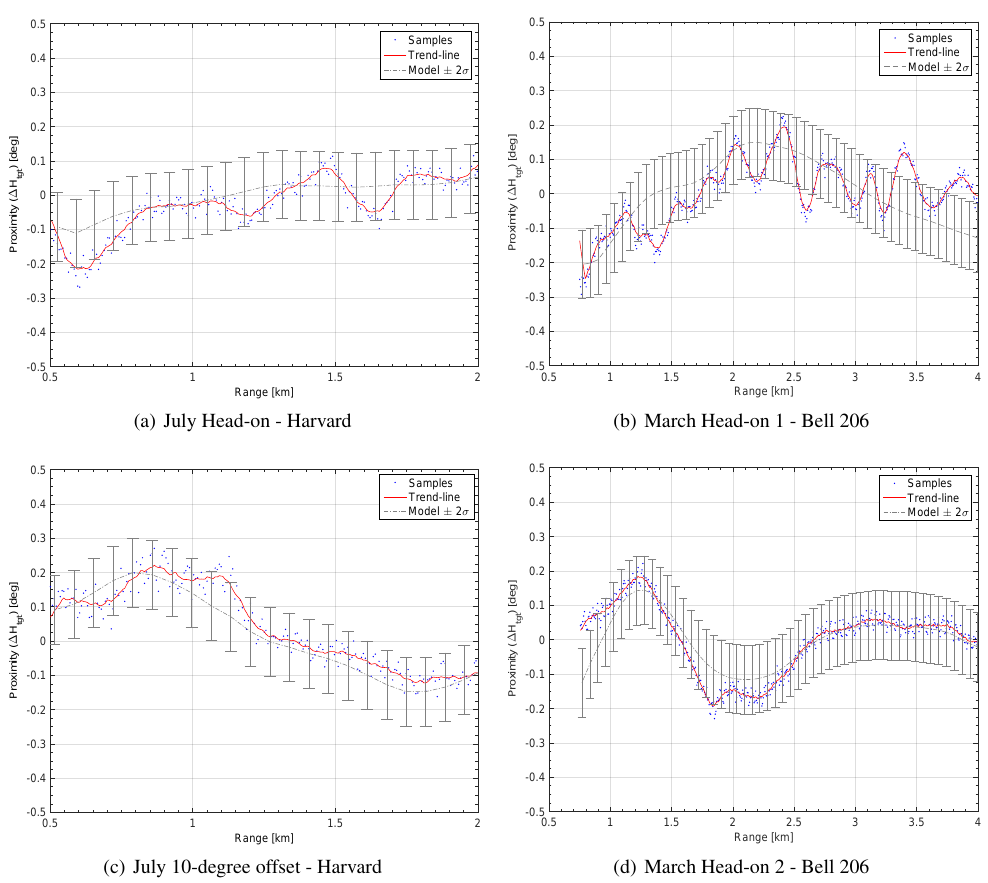
Figure 5: Temporal VHP profiles from the July 2009 and March 2012 datasets. Individual data points (in blue) represent the per-frame VHP (Eq. 5) converted into degrees via the known camera scale factor. A trend-line (in red) is shown to enhance readability. The dotted grey line with error bars illustrates the modeled proximity (Eq. 6). The height of the error bars is derived from the ± 2 σ = 0 . 1 deg error in the on-board INS attitude measurements.